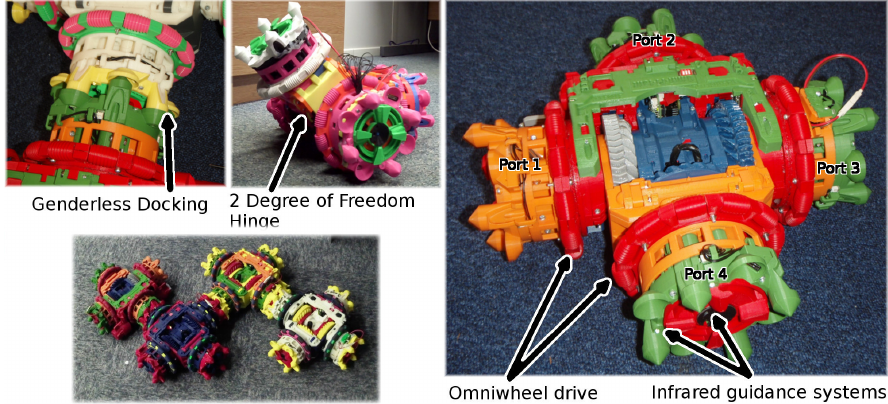
Figure 1. Photographs of an Omni-Pi-tent